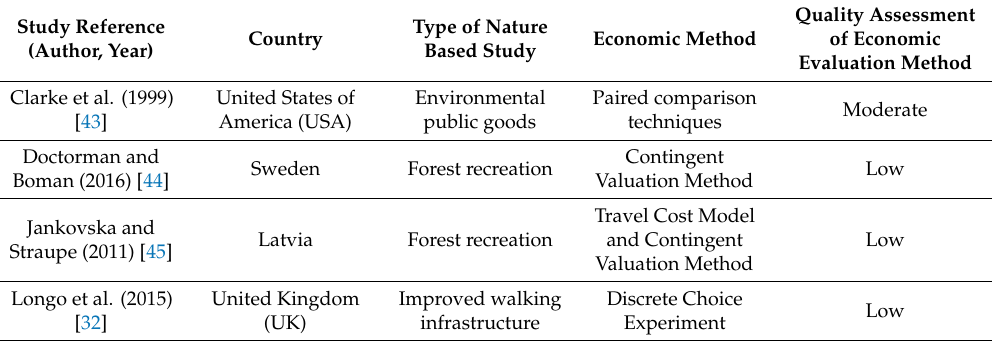
Table 1. Characteristics and quality assessment of the included articles.